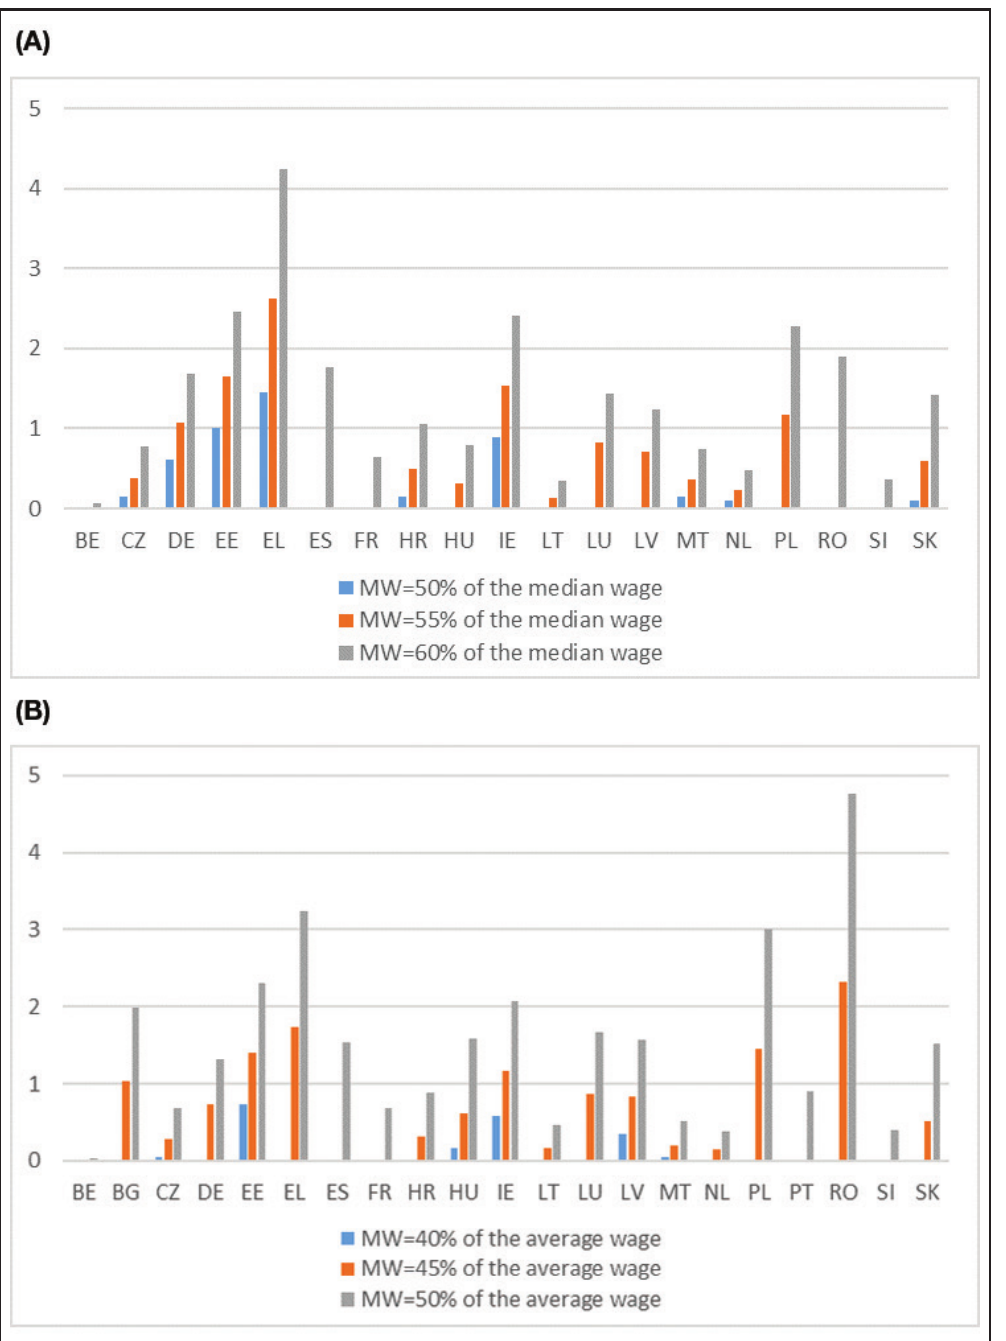
Figure A6 Change in the total wage bill as a result of changes in the MWs